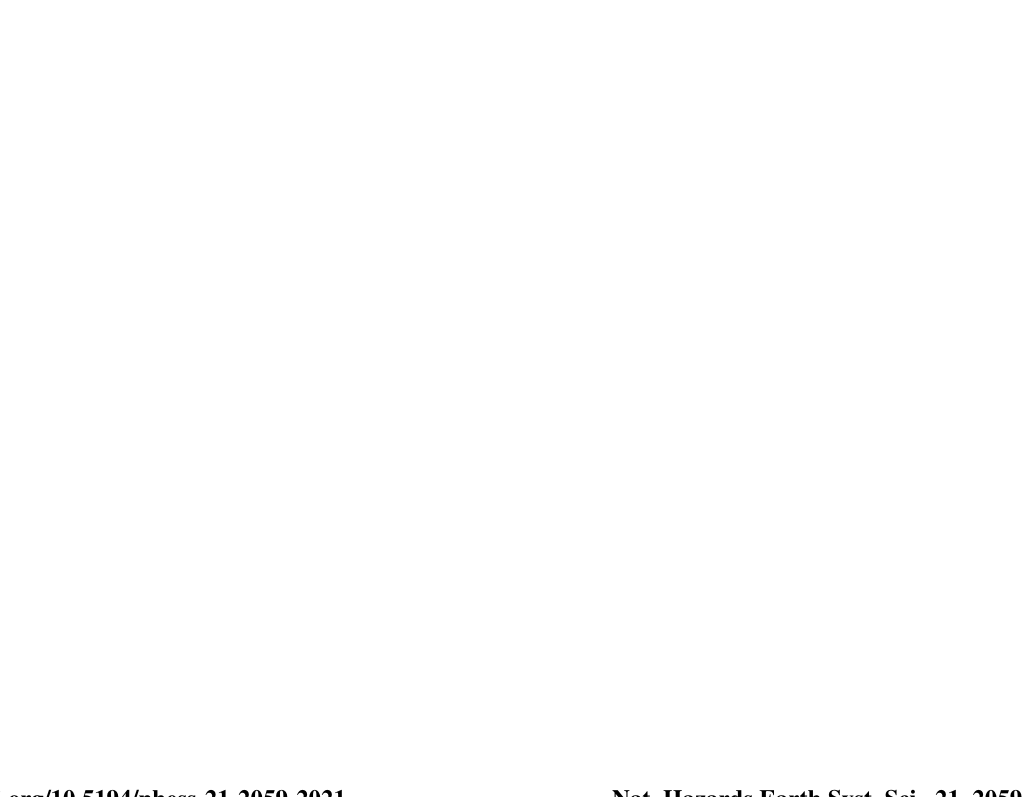
Tabriz Seismological Observatory